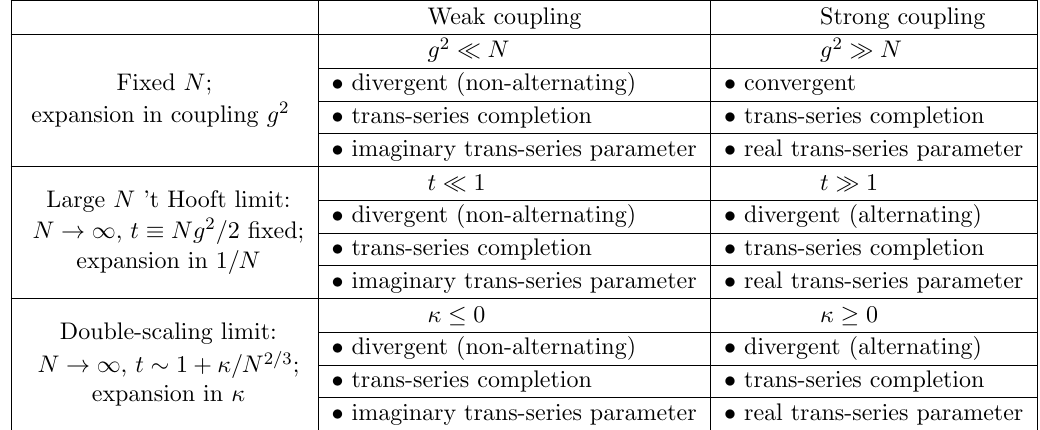
Table 1 . The basic structure of the weak-coupling and strong-coupling expansions of the free energy ln Z ( g 2 ; N ) in three physical limits. At (cid:12)xed N , the weak coupling expansion is